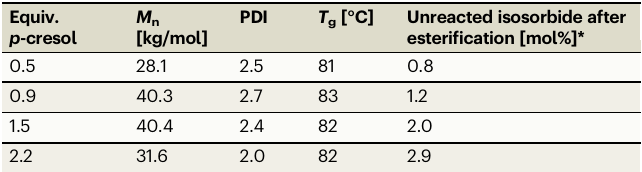
Table 2 | In fl uence of p -cresol equivalents on molecular weight and T g of PIsSu